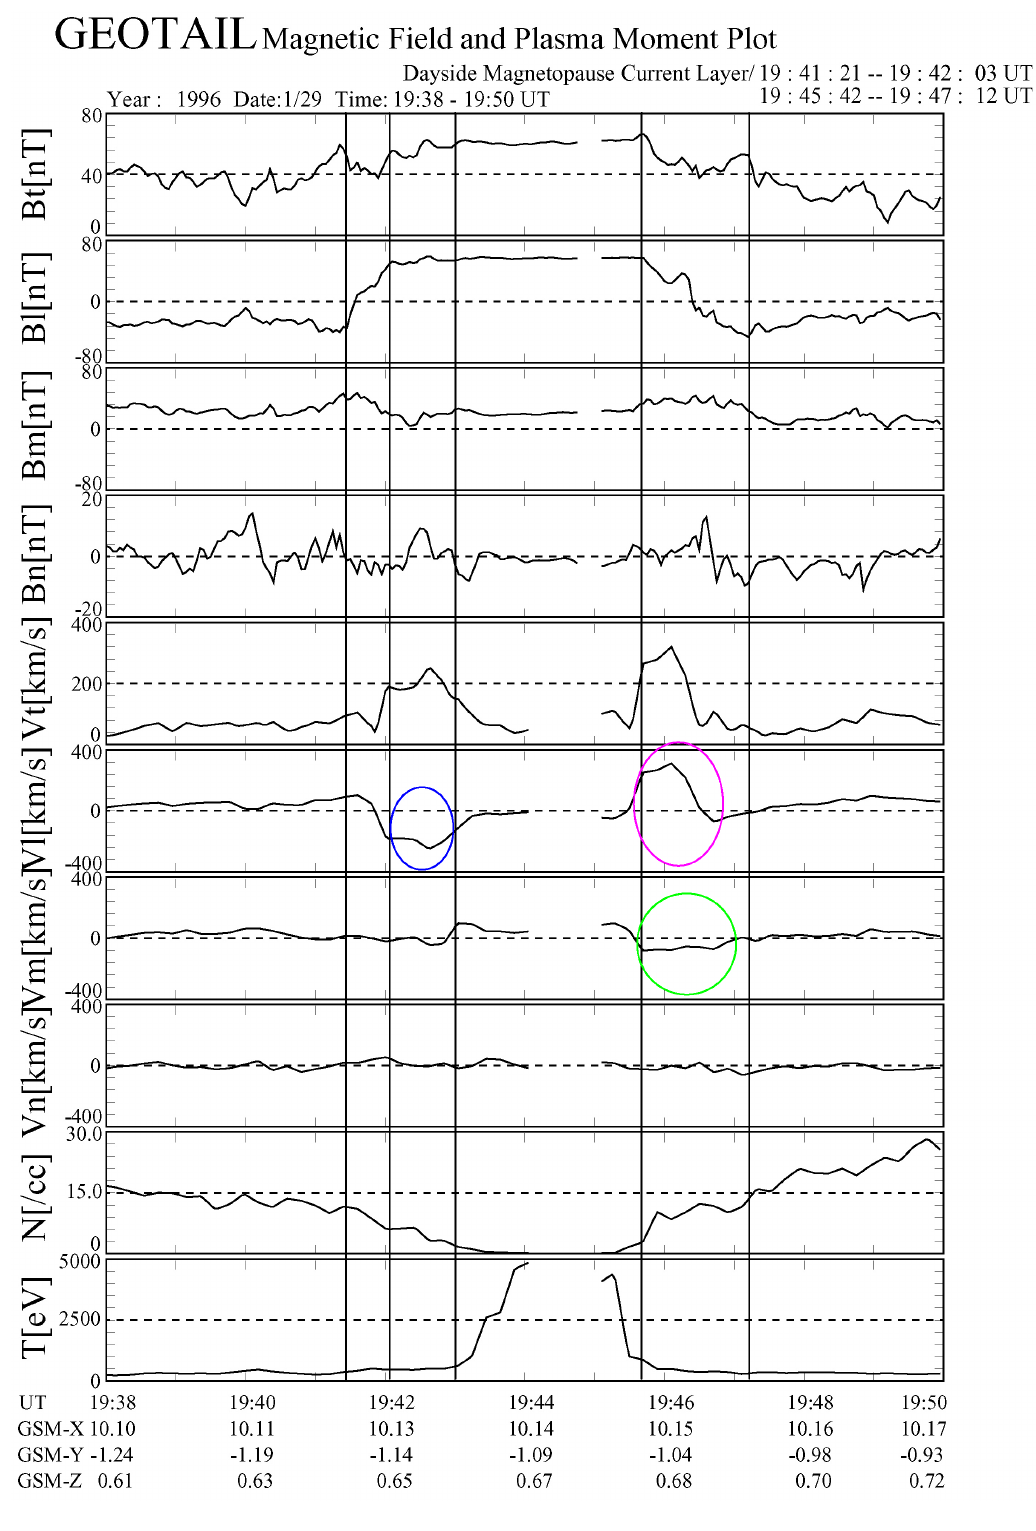
Figure 3 Fig. 3. A plot of GEOTAIL observations during the interval of 12min from 19:38:00 UT to 19:50:00 UT on 29 January 1996. From top